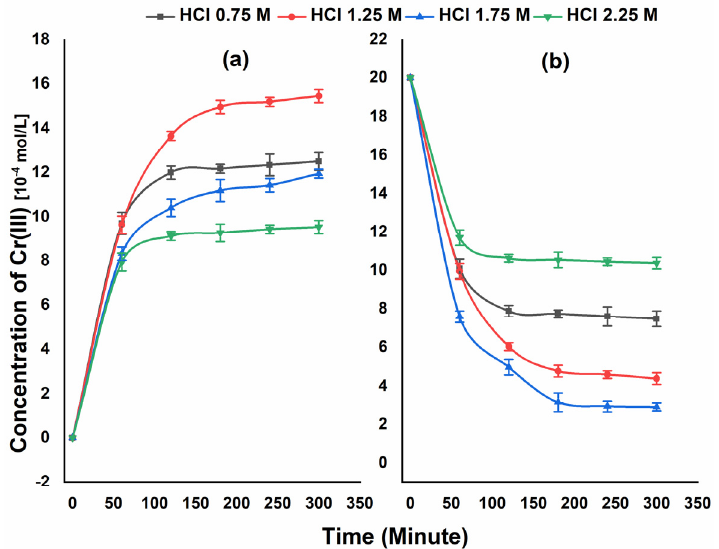
Figure 7. Concentration of Cr (III) in feed phase ( a ) and stripping phase ( b ) at various D2EHPA concentrations; [CrIII] = 20 × 10 − 4 mol/L, [HCl] = 1.25 mol/L.